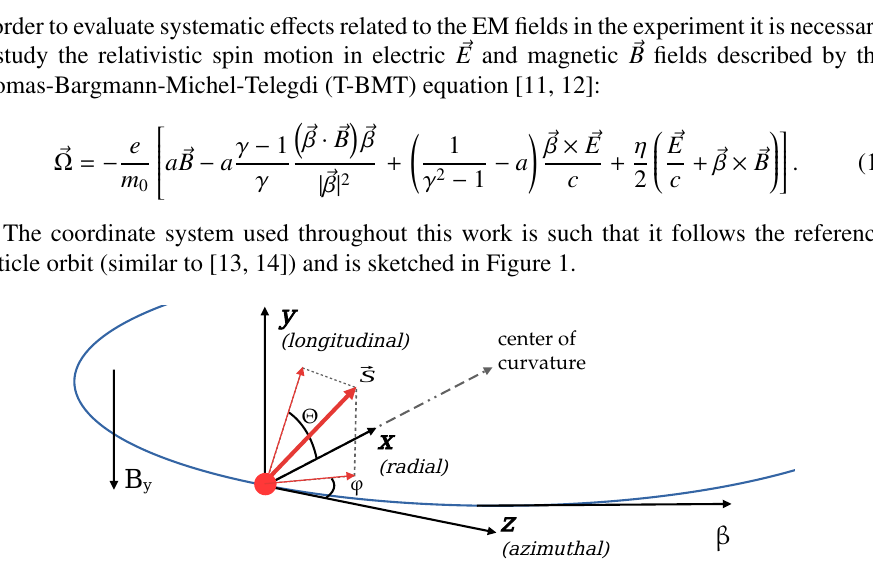
Figure 1. The local reference coordinate system used to derive the motion of the spin in the EM fields of the experiment. The vector ˆ z follows the momentum of the muon and ˆ y always points along the longitudinal direction defined by the main solenoid magnetic field B y